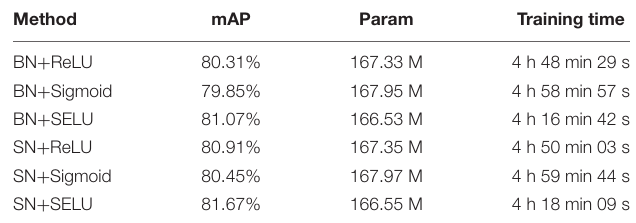
TABLE 8 | Exploring the combination of normalized processing and activation